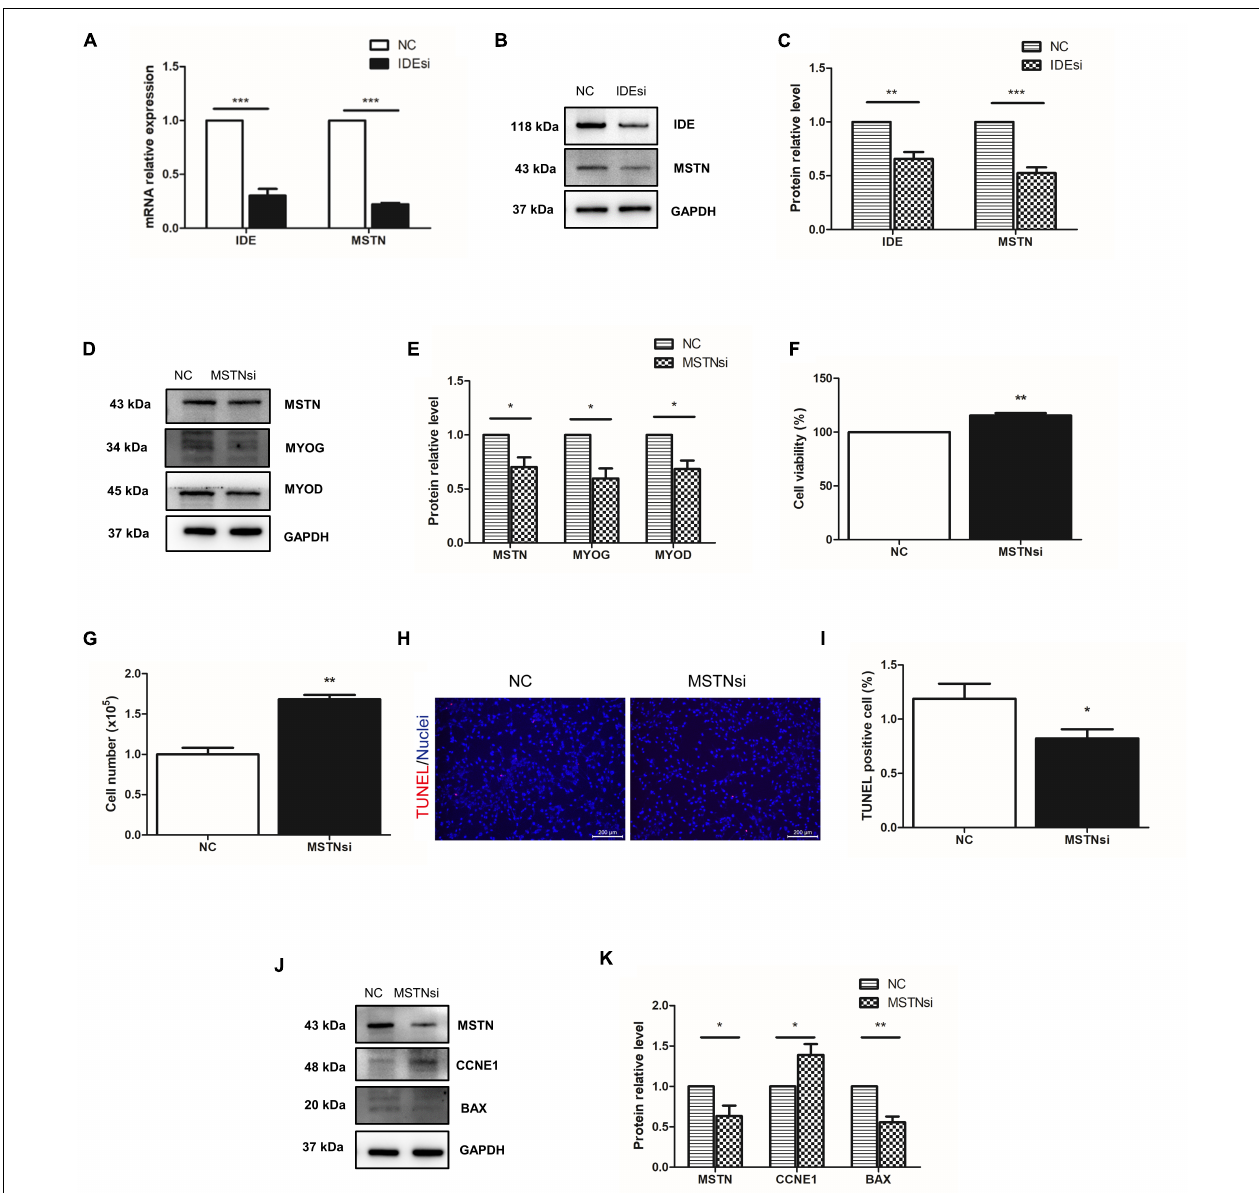
FIGURE 5 | IDE regulates PSMSCs through MSTN / MYOD pathway. (A) One of downregulated DEGs, MSTN , is confirmed its downregulation in PSMSCs transfected with IDEsi for 48 h compared with that in NC group PSMSCs in both mRNA (A) and protein levels (B,C) via RT-qPCR assay and western blotting analysis, respectively. (D,E) MSTN knockdown reduces the protein levels of MSTN and MYOD in PSMSCs. (F,G) CCK-8 assay and cell number show that cell proliferation is enhanced in MSTNsi group than that in NC group after siRNA transfection into PSMSCs for 48 h. (H,I) TUNEL assay showed that MSTN knockdown exhibited less apoptotic cells than control group. (G,H,J,K) Downregulation of MSTN leads to increase in the protein level of CCNE1 and decrease in the protein levels of MSTN and BAX in PSMSCs. * P < 0.05, ** P < 0.01, and *** P <